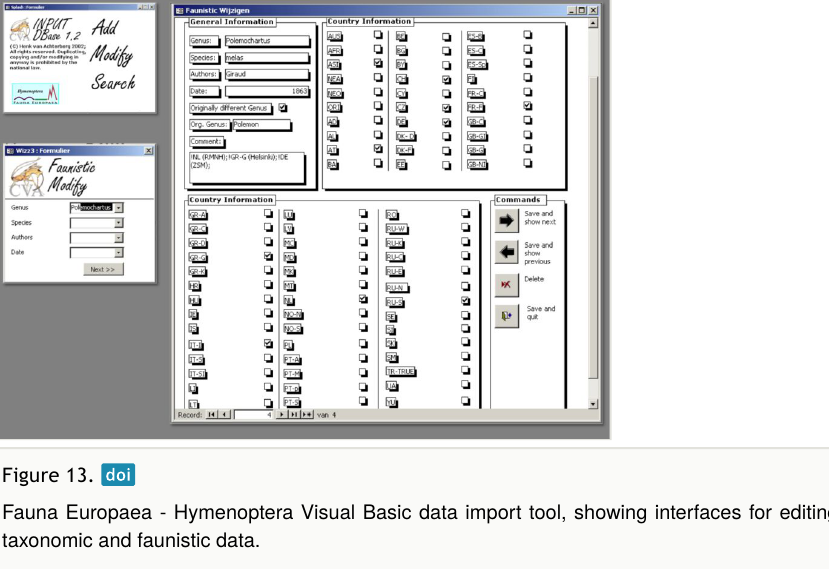
Fauna Europaea - Hymenoptera Visual Basic data import tool, showing interfaces for editing taxonomic and faunistic